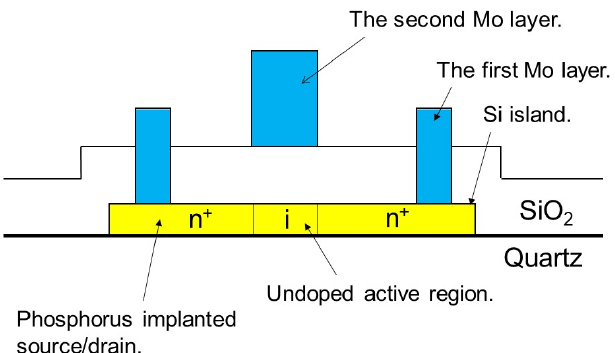
Figure 1. Schematic view of the structure of the fabricated